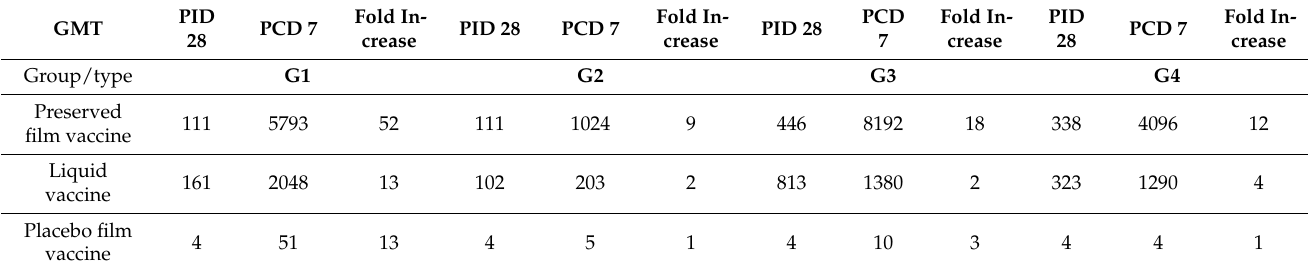
Table 2. Serum VN antibody GMT increases from prechallenge (PID 28) to postchallenge (PCD 7). PID Fold In- GMT PCD 7 28 crease PID GMT Group/type G1 G2 G3 G4 Preserved 111 film vaccine Liquid vaccine Placebo film